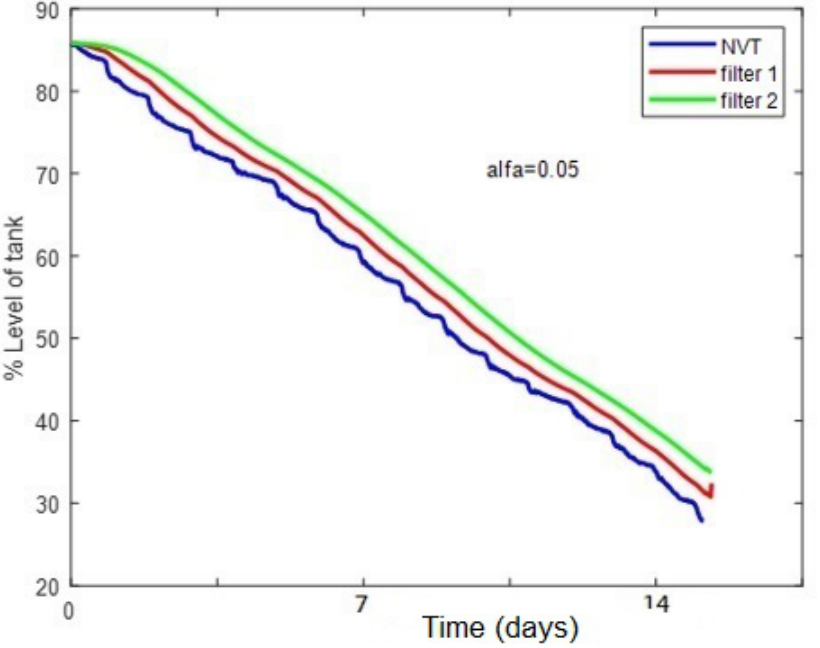
Figure 10. Temporal pattern of NVT real and Brown-filtered signals for α = 0.05.